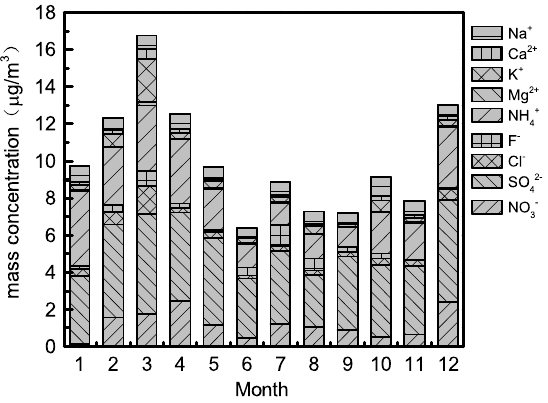
Figure 3. Monthly variations in water-soluble inorganic ions Table 3 showed comparison between our SIAs results and previous studies. Except for Wuhan (58.0%), SIAs accounted for 31.9% ~ 47.9% of PM 2.5 concentration in Chinese cities. PM 2.5 mass concentrations in Veneto (Italy) and Thessaloniki (Greece) were similar to that in Xiamen, and SIAs accounted for about 35% of PM 2.5 mass concentration in these three cities. The combined percentages of SIAs in PM 2.5 were relatively lower in Delhi (India) and Budapest (Hungary). The differences in contribution of SIAs to PM 2.5 among cities might because of variations in energy structure, economic structure, geological condition, meteorological characteristics and population density.